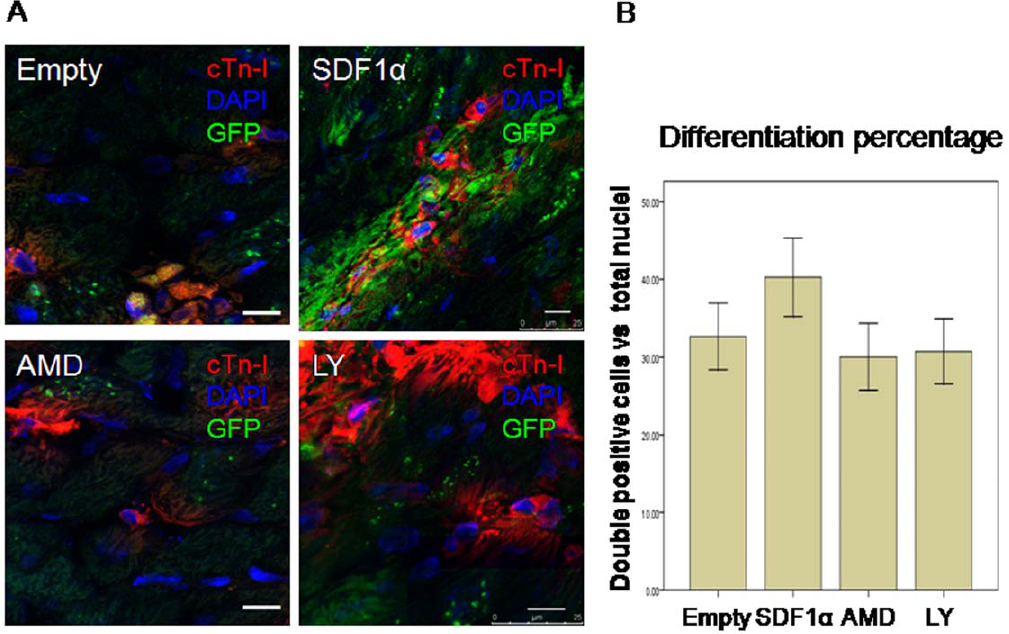
Figure 5. Differentiation of transplanted CSCs in infarcted zone. A . differentiation of transplanted CSCs was determined by cTn-I and DAPI double staining (red and blue) 3 weeks after myocardial infarction. Scale bar=10 um. B . Quantitative analysis of the ratio of cTn-I/DAPI double positive cells. Data were shown as mean 6 SD. n=6. doi:10.1371/journal.pone.0043922.g005 PLOS ONE |